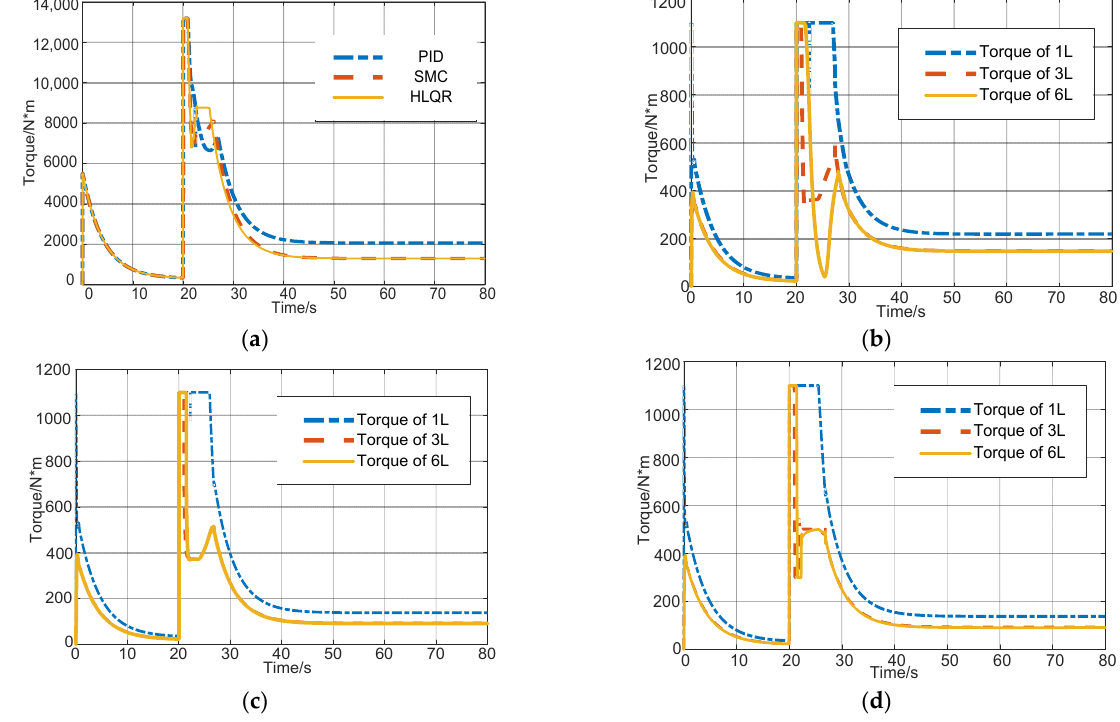
Figure 6. On the changed road surface: ( a ) total driving torque; torque of left wheel for the 1st, 3rd, and 6th axles; ( b ) controlled by PID; ( c ) controlled by SMC; ( d ) controlled by HLQR. The wheel slip ratio controlled by the PID, SMC, and HLQR algorithms is shown in Figures 7–9, respectively. In each figure, the slip ratios of wheels 1 L, 3 L, and 6 L are presented. The results indicate that the vehicle accelerates and drives from the high adhesion road to the low adhesion road in 20 s. Then, the slip ratios of the 3rd axle and 6th axle increase sharply. Anti-skid control is activated based on the optimal slip ratio calculation. Then, the torque distribution results are constrained by the slip control results. However, it should be noted that the actual moment when each anti-skid control method is triggered and turned off is not exactly the same. This is because the difference between